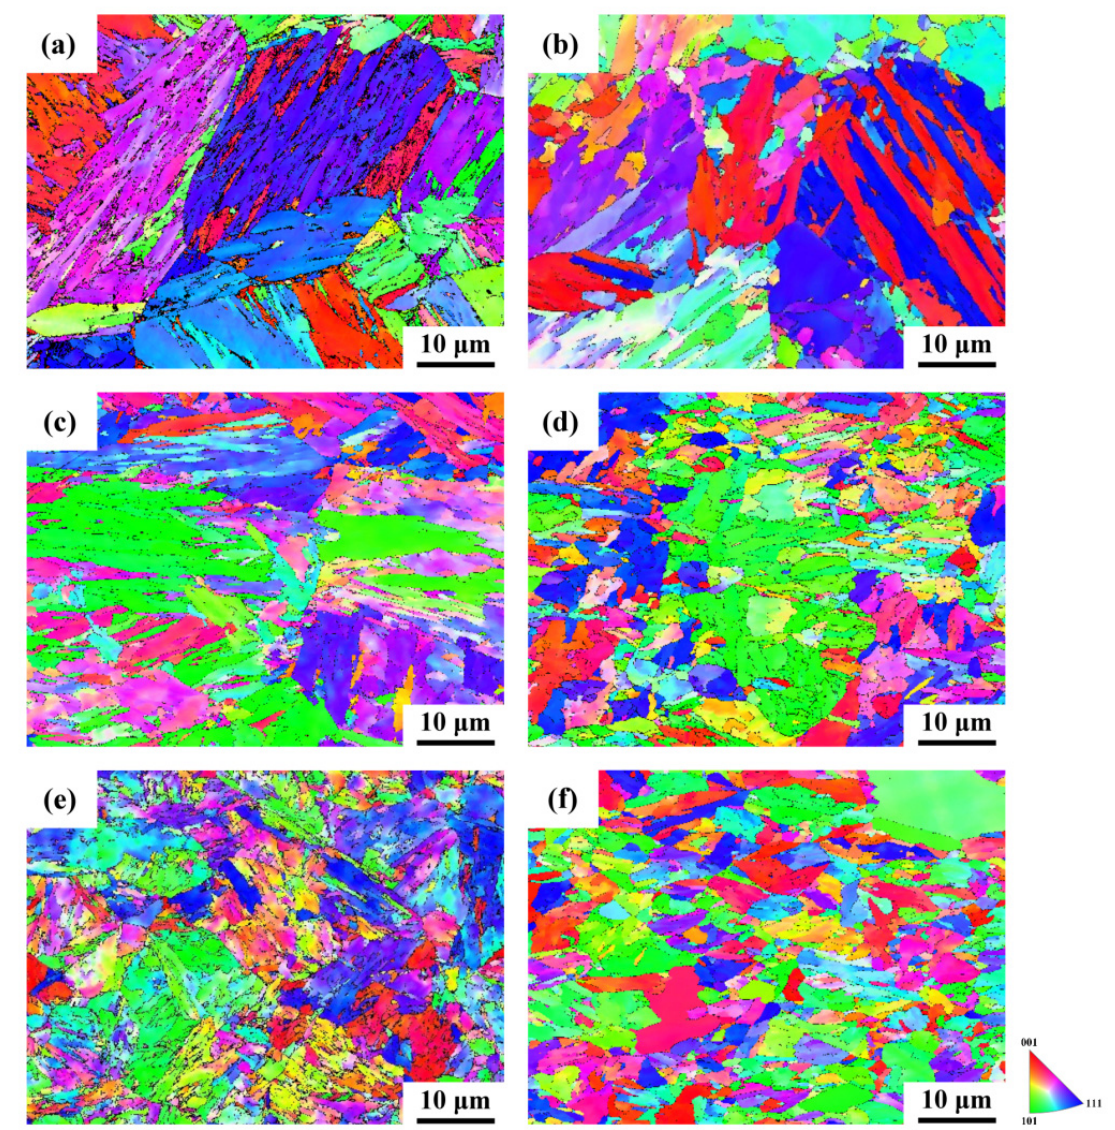
Figure 7. The inverse pole figures (IPFs) of the ( a ) W, ( b ) WP, ( c ) WP-800, ( d ) WP-800P, ( e ) WP-860 and ( f ) WP-860P specimens.